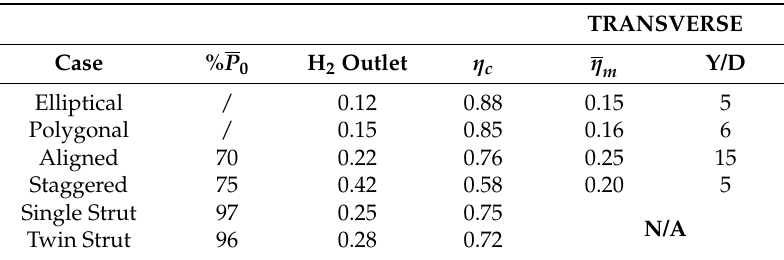
Table 6. Injector case performance data.